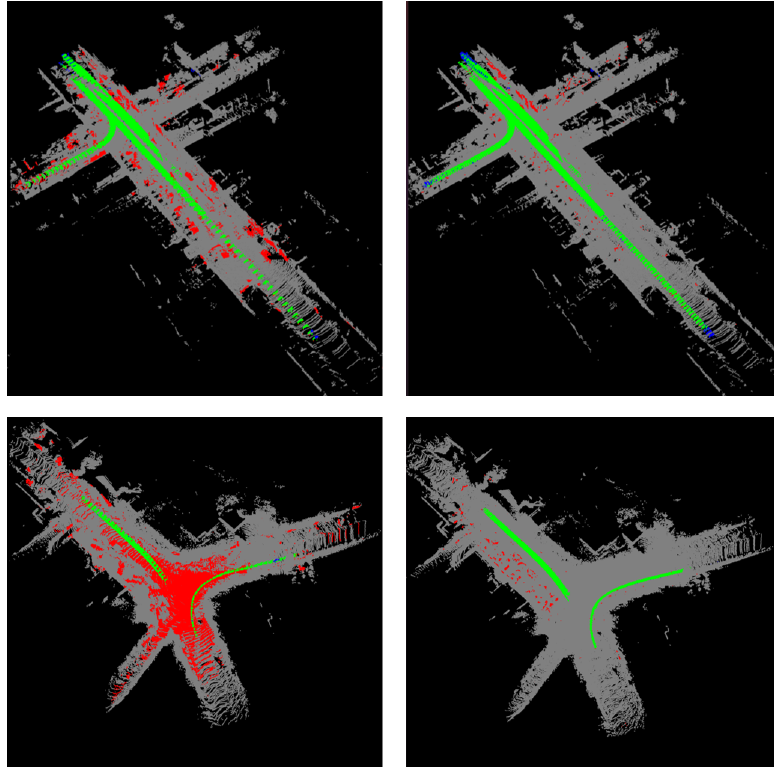
Figure 10. The left two figures shows the errors that occurred in ERASOR, whereas the right shows the errors in our approach. The true positives, true negatives, false positives, and false negatives are colored in green, gray, red, and blue, respectively.